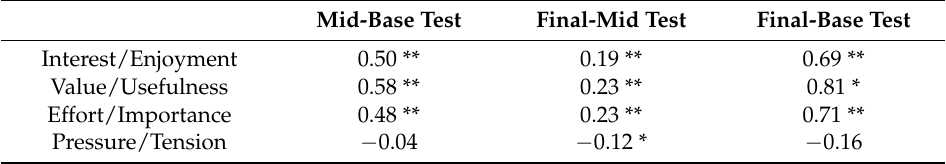
Table 5. Mean differences for the four subscales of the IMI [37] for all students, regardless of